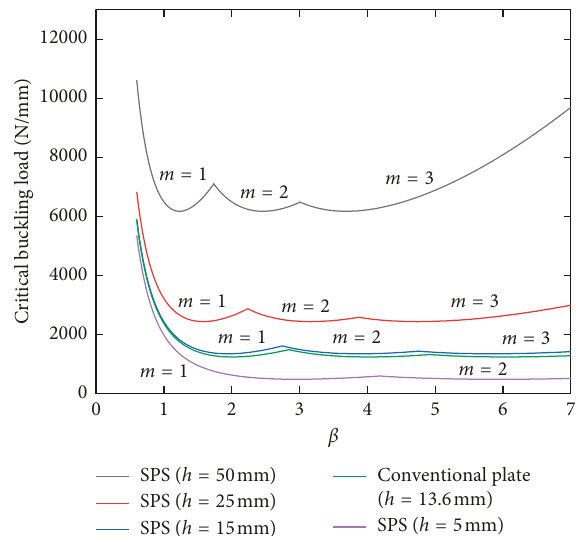
Figure 6: Relation between critical buckling load and β for dif- ferent core